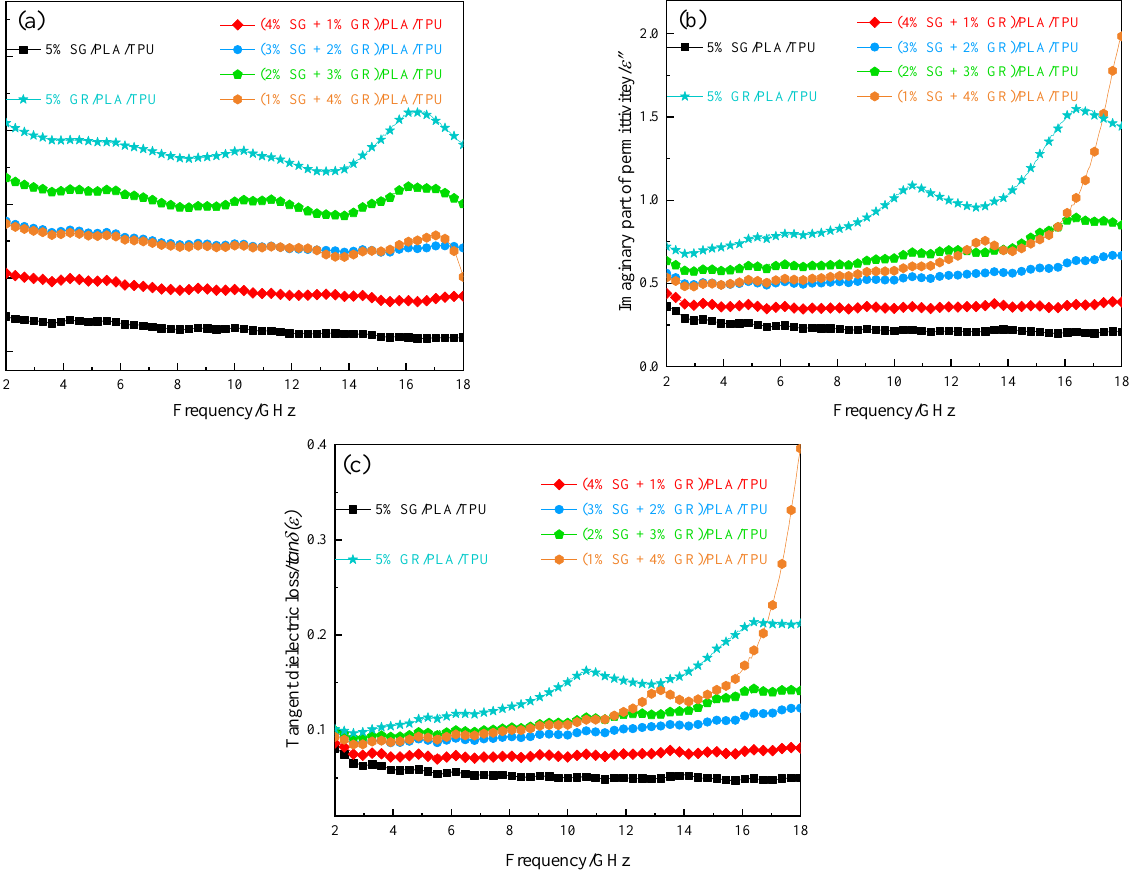
Figure 6. Electromagnetic parameters of six kinds of SG/GR/PLA/TPU composites with different contents: ( a ) real part of permittivity; ( b ) imaginary part of permittivity; ( c ) tangent dielectric loss. Dielectric materials are mainly characterized by interfacial polarization, dipole polarization loss and conductance loss in the microwave absorption frequency band [19,20], which are generally characterized by the Debye equation [21]: